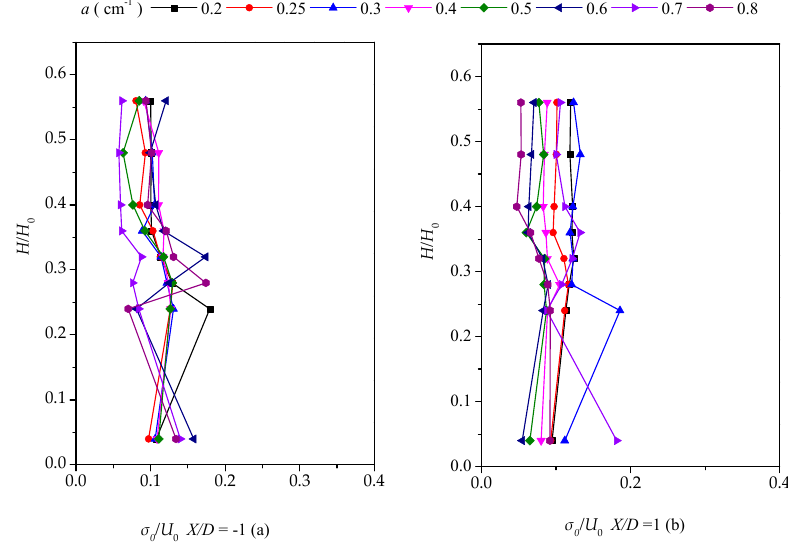
Figure 6. Vertical distributions of the turbulence intensity.